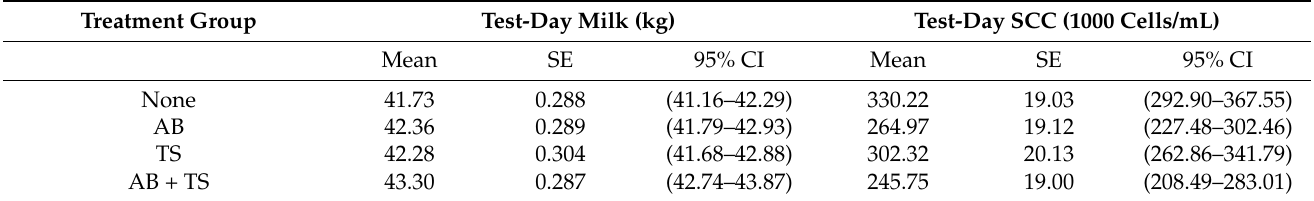
Table 2. Mean test-day milk production and mean test-day SCC during the first 150 DIM from eight herds block randomized to one of four treatments at dry-off (AB, TS, AB + TS, None)